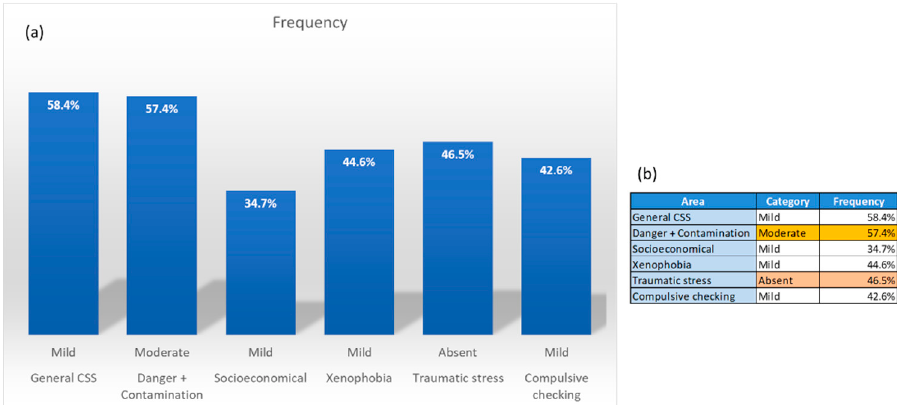
Figure 1. Most representative COVID-19 stress level frequency for healthcare providers by area. ( a ) Graph of frequencies in relation to areas. ( b ) Table showing the most representative frequencies in each area. Areas of socioeconomics, xenophobia, and compulsive checking show levels of mild stress, Danger and contamination show levels of moderate stress, and traumatic stress shows an absence of stress. Table 2. COVID-related stress frequency for healthcare providers correlated to the general CSS and studied individual areas.